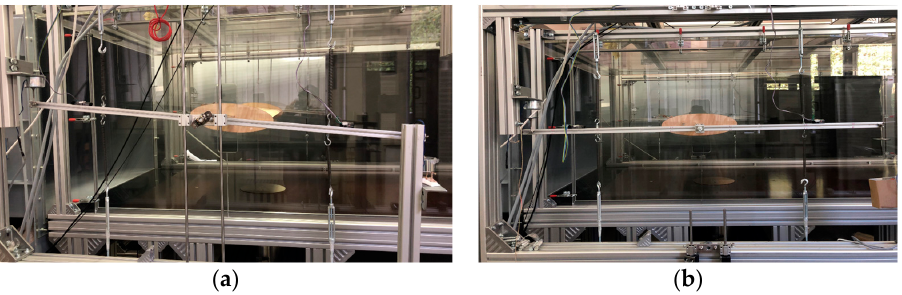
Figure 11. Two-degree-of-freedom assembly: ( a ) Setup 1, utilizing all components; ( b ) Setup 2, without bearing assemblies.